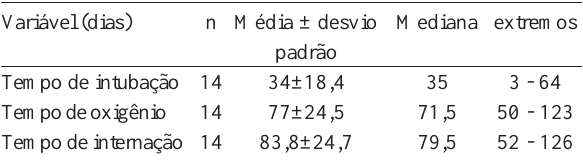
dois grupos: A - clínico (n = 6), tratadas exclusivamente com inibidores de prostaglandina; B - cirúrgico (n = 8),